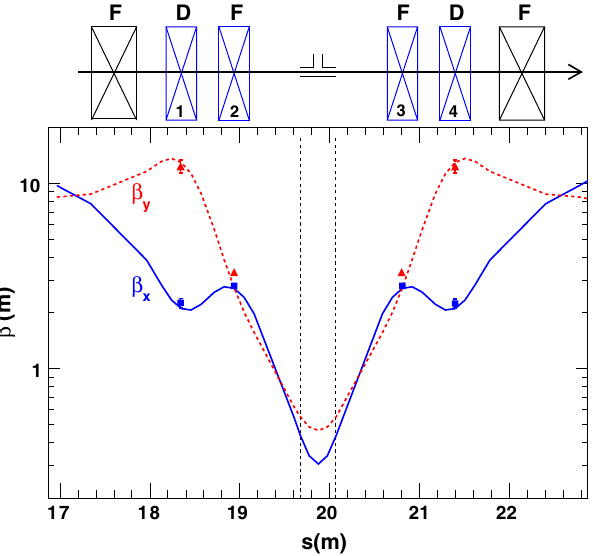
FIG. 16. Model calculation of the β -functions at the PAX-TP ¯ β ¯ β and measured values of and at the magnet positions. The x y four new PAX quadrupole magnets are shown in blue. Magnets 1 and 4 form the defocusing (D) pair (PAX1) and magnets 2 and 3 the focusing (F) pair (PAX2), where each pair is operated with a single power supply. In addition, the storage cell and the beam direction are shown. shown in Fig. 16 together with the result of the model calculation, which yields reasonable agreement (see ¼ 0 . 31 m and Table III) with the measured data and β x β ¼ 0 . 46 m at the center of the target. From a comparison y FIG. 15. Betatron tunes Q (horizontal) and Q (vertical) as a of measured and calculated betatron functions, an uncer- x y function of the focusing strength k for the inner (top panel) and x;y tainty of about 10% is estimated for the β -functions outer (bottom panel) pair of the PAX low- β quadrupoles. The data obtained from the MAD model. were fitted with a hyperbola, and the slopes of the asymptotes j Δ Q = Δ k j were used to determine the β -functions. Δ Q split is a x;y measure of coupling in the machine.